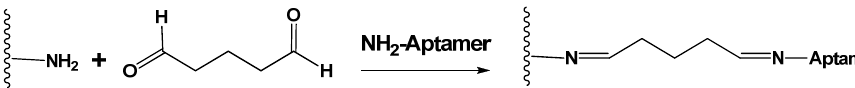
Figure 5. Glutaraldehyde cross-binding of aminated aptamer and carrier.